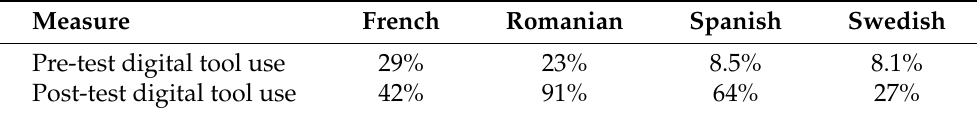
Table 2. Percentage of digital tool use on pre- and post test for the separate languages.